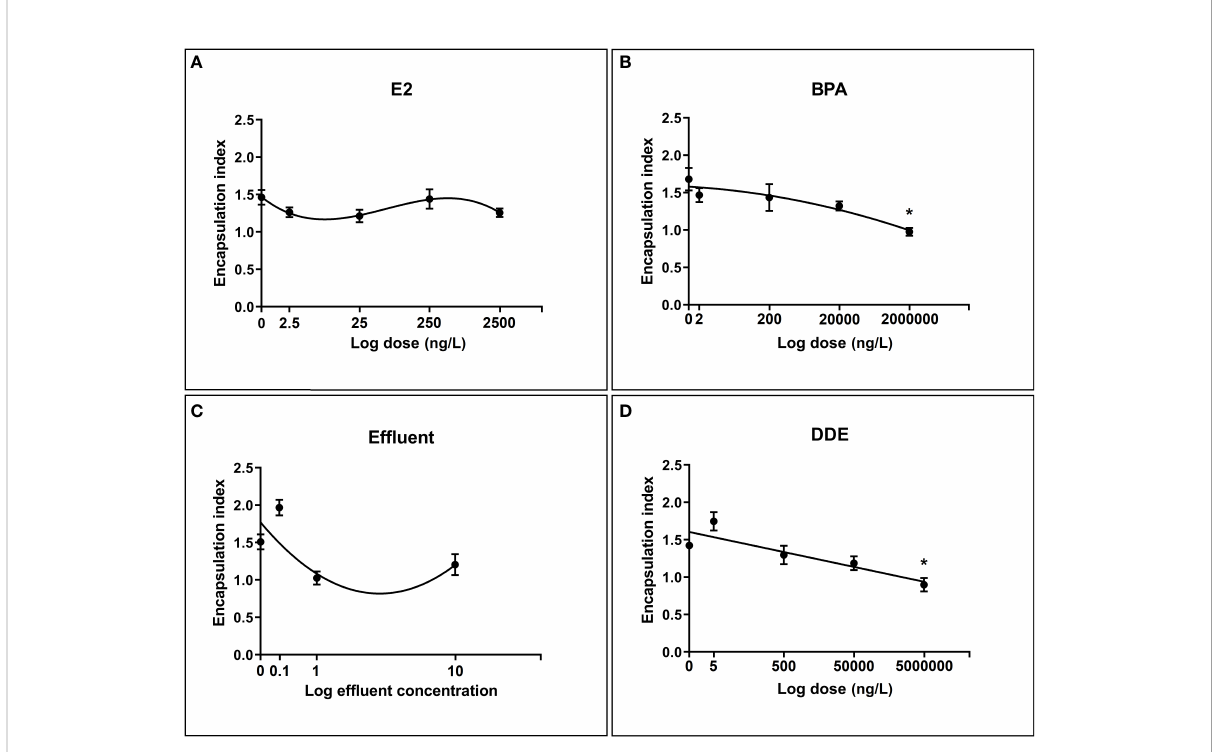
FIGURE 3 Regression relationships between log dose of test chemicals against encapsulation response toward S. mansoni sporocysts by B glabrata hemocytes exposed in vitro . Hemocyte response plotted as mean encapsulation index value ± SEM of three independent replicates. (A) Hemocyte encapsulation response to E2 exposure (B) Hemocyte encapsulation response to BPA exposure (C) Hemocyte encapsulation response to Ef fl uent exposure (D) Hemocyte encapsulation response to p,p ’ -DDE exposure. Asterisks indicate signi fi cant differences to the respective control (p = < 0.05) according to Dunnett ’ s test for multiple